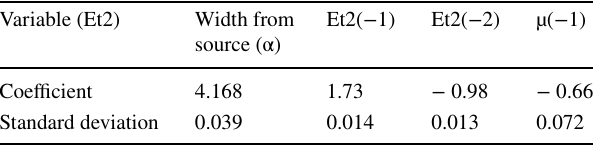
Table 3 Conditional mean equation evapotranspiration by the Har-